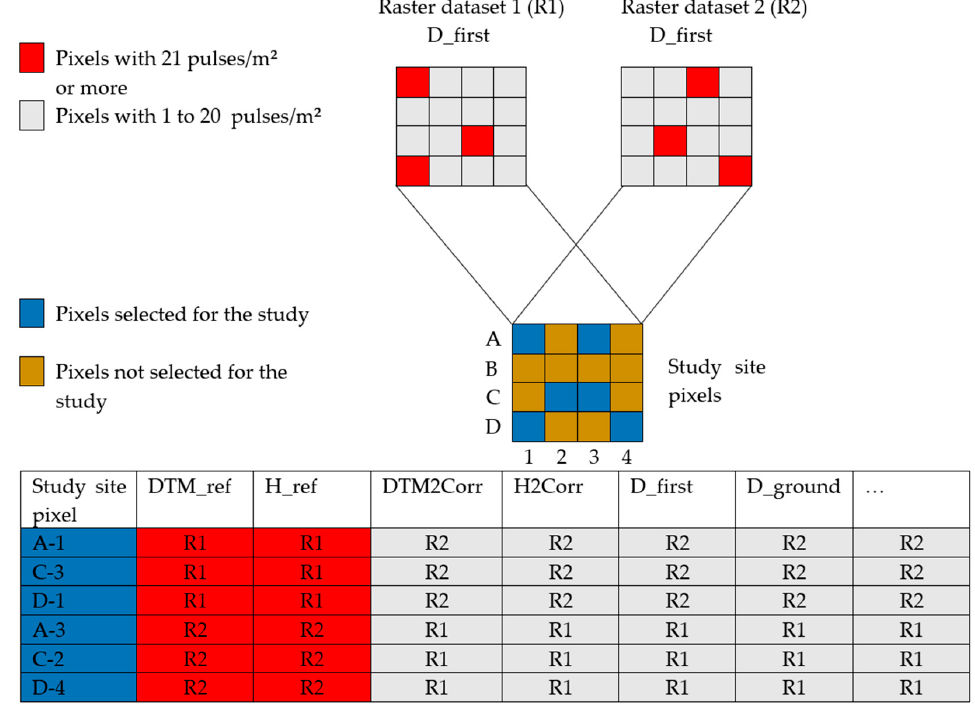
Figure 3. Schema for the generation of the database.